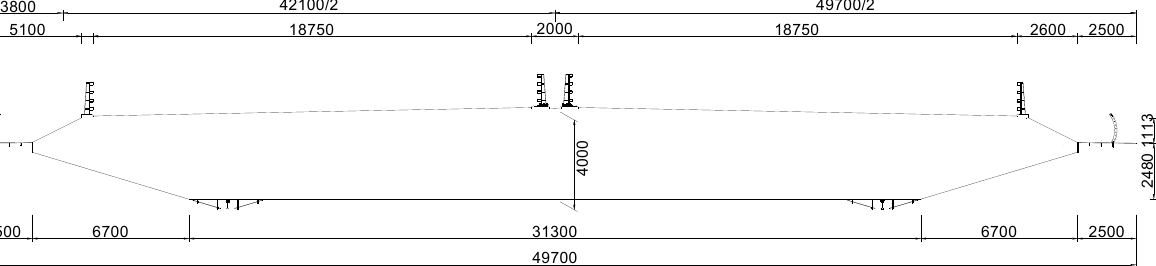
Figure 12. Local mesh division of the computational domain ( a ) near the main deck section; ( b ) near the maintenance vehicle tracks; and ( c ) near the sidewalk outriggers. To study the first-order Volterra model in more nonlinear aerodynamic conditions, the wind-induced vibration responses of the main deck section of LDYB for different wind speeds near the flutter critical wind speed are calculated by ROM and FSI, respectively. The main parameters of the main deck section of LDYB are given in Table 5. Figure 13 shows the numerical results of wind-induced vibration responses of the main deck section by ROM method for incoming wind speeds of 75 m/s and 80 m/s for